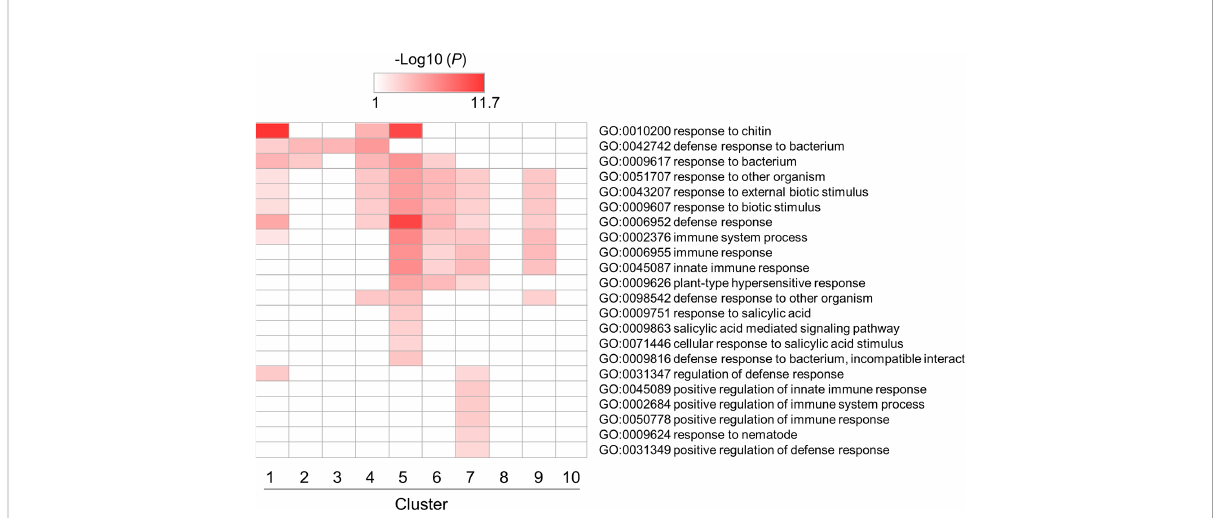
FIGURE 4 Gene ontology (GO) enrichment analysis of defense-related DEGs identi fi ed in fl g22-treated Brachypodium distachyon leaf disks. The p -values of 22 GO terms in each cluster were analyzed, converted to logarithmic values (-Log10), and displayed as a heatmap, with darker colors indicating over-representation.